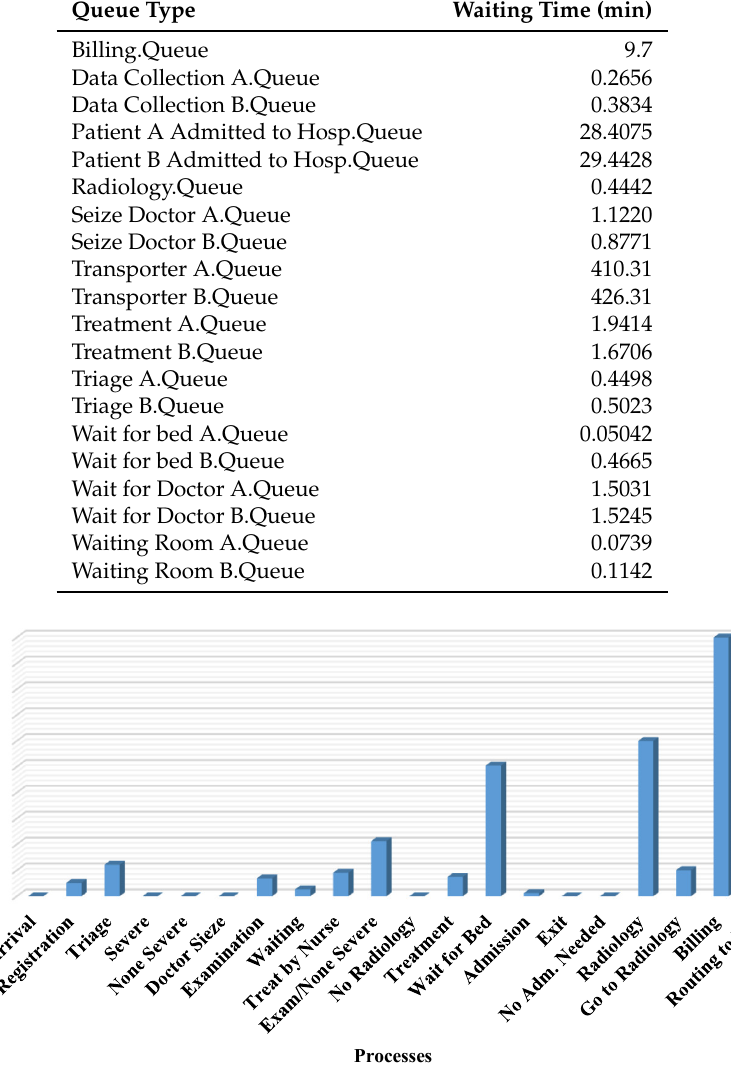
Table 5. Average time in queues.